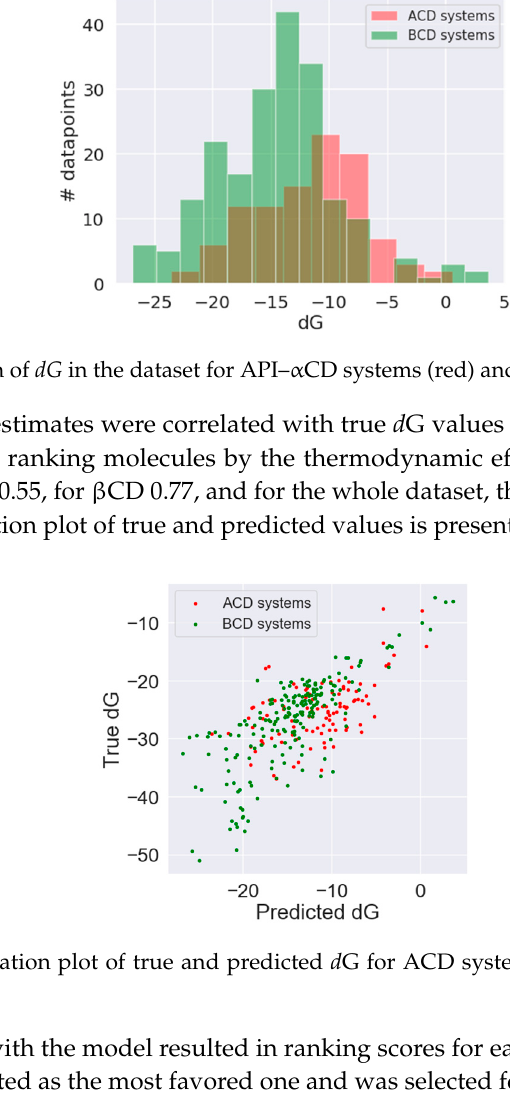
Table 1. Virtual screening results.